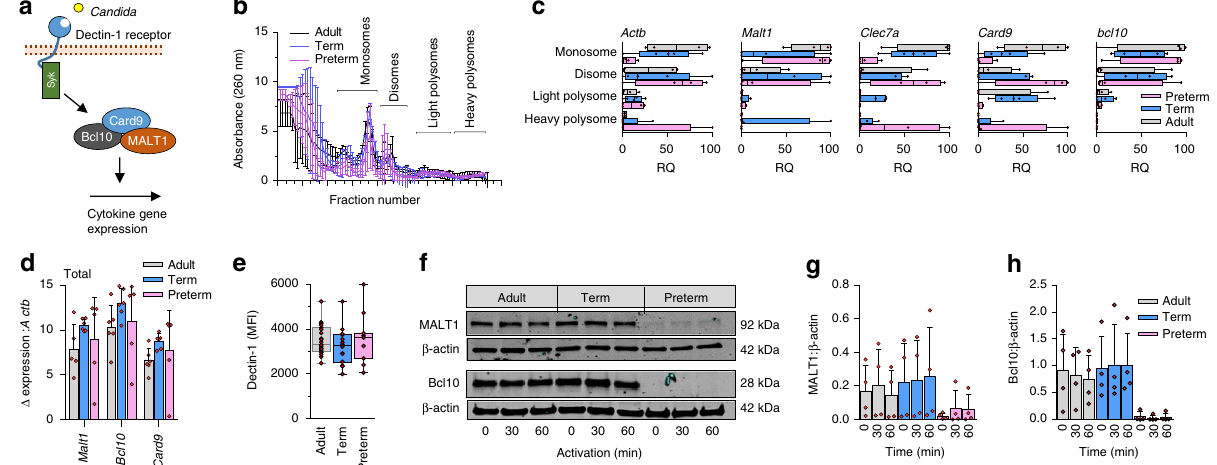
Fig. 5 Gene expression and translation of dectin-1 signaling proteins. a Illustration of selected signaling molecules downstream of dectin-1; b Polysome pro fi les and c quanti fi cation of signalosome genes (qPCR) in monosome, disome, and light and heavy polysome fractions (monocytes). Data are from 4 subjects per age group (boxes and whiskers; RQ = relative quanti fi cation); d Quanti fi cation of signalosome genes (qPCR) in total RNA fractions (4 to 5 subjects/age group; mean ± SD); e Surface expression of dectin-1 ( fl ow cytometry, mononuclear cells, gated on CD14-expressing cells; data pooled from 10 to 23 subjects per age group; boxes and whiskers); f Representative (cropped) Western blot of MALT1 and Bcl10 protein expression in monocytes after 0 to 60 min LPS stimulation. Representative blot is from a 29 weeks gestation sample. Images cropped from same blot probes with each antibody; cumulative quanti fi cation of 4 independent Western blot experiments for g MALT1 and h Bcl10 (mean ± SD)